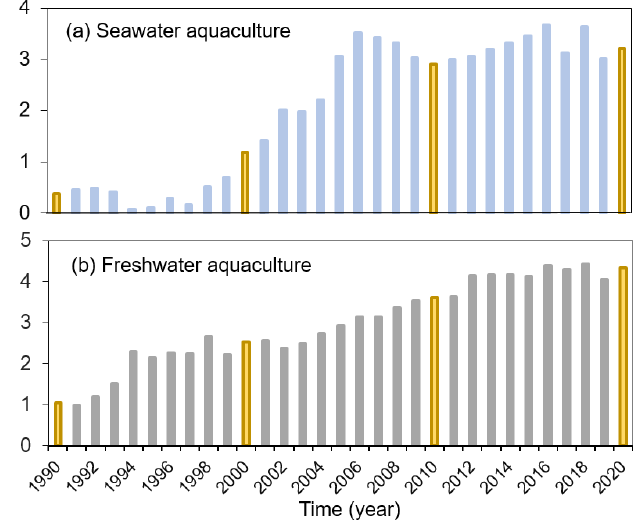
Figure 7. Changes of aquaculture yield per unit area in Dongying City from 1990 to 2021. The yellow columns represent the years of the study, 1990, 2000, 2010 and 2020.